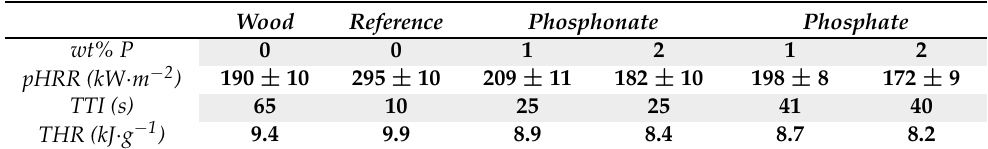
Table 5. Results of cone analyses of reference EC alkyd resin and POxCR diluent EC alkyd